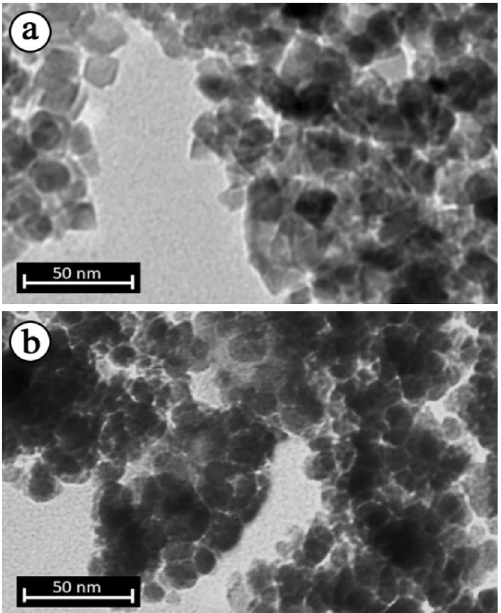
Figure 5. TEM images of Fe 3 O 4 ( a ) and Fe 3 O 4 @SiO 2 @TAD-G3 ( b ).